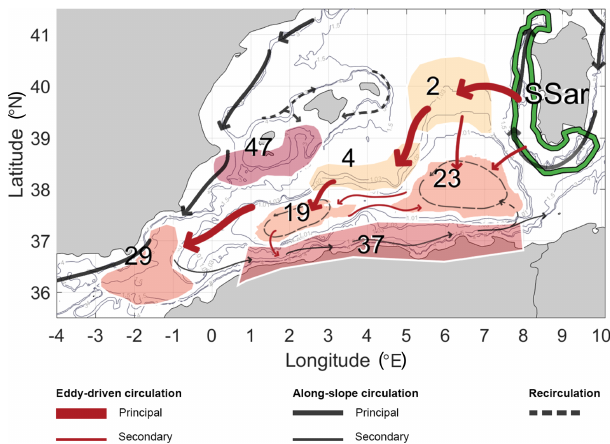
Figure 9. Circulation scheme of LIW in the Algerian Basin inferred from the cross-correlation analysis. The transit time (indicated in months on top of each polygon) was obtained from the propagation of the cooling signal in the 1974–1992 period traveling from the south Sardinia area (green polygon). The color of the polygons here is to provide a visual aspect of the transit time result: the redder the color, the larger the transit time. The solid gray arrows repre- sent the mean along-slope intermediate circulation redrawn from Millot and Taupier-Letage (2005b). The solid red arrows represent the eddy-driven transport inferred from the result of the time transit analysis. The dashed gray arrows represent recirculation from the along-slope